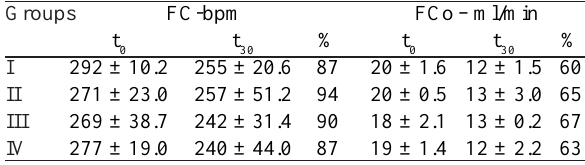
Table 1. Heart rate and Coronary flow average results Groups